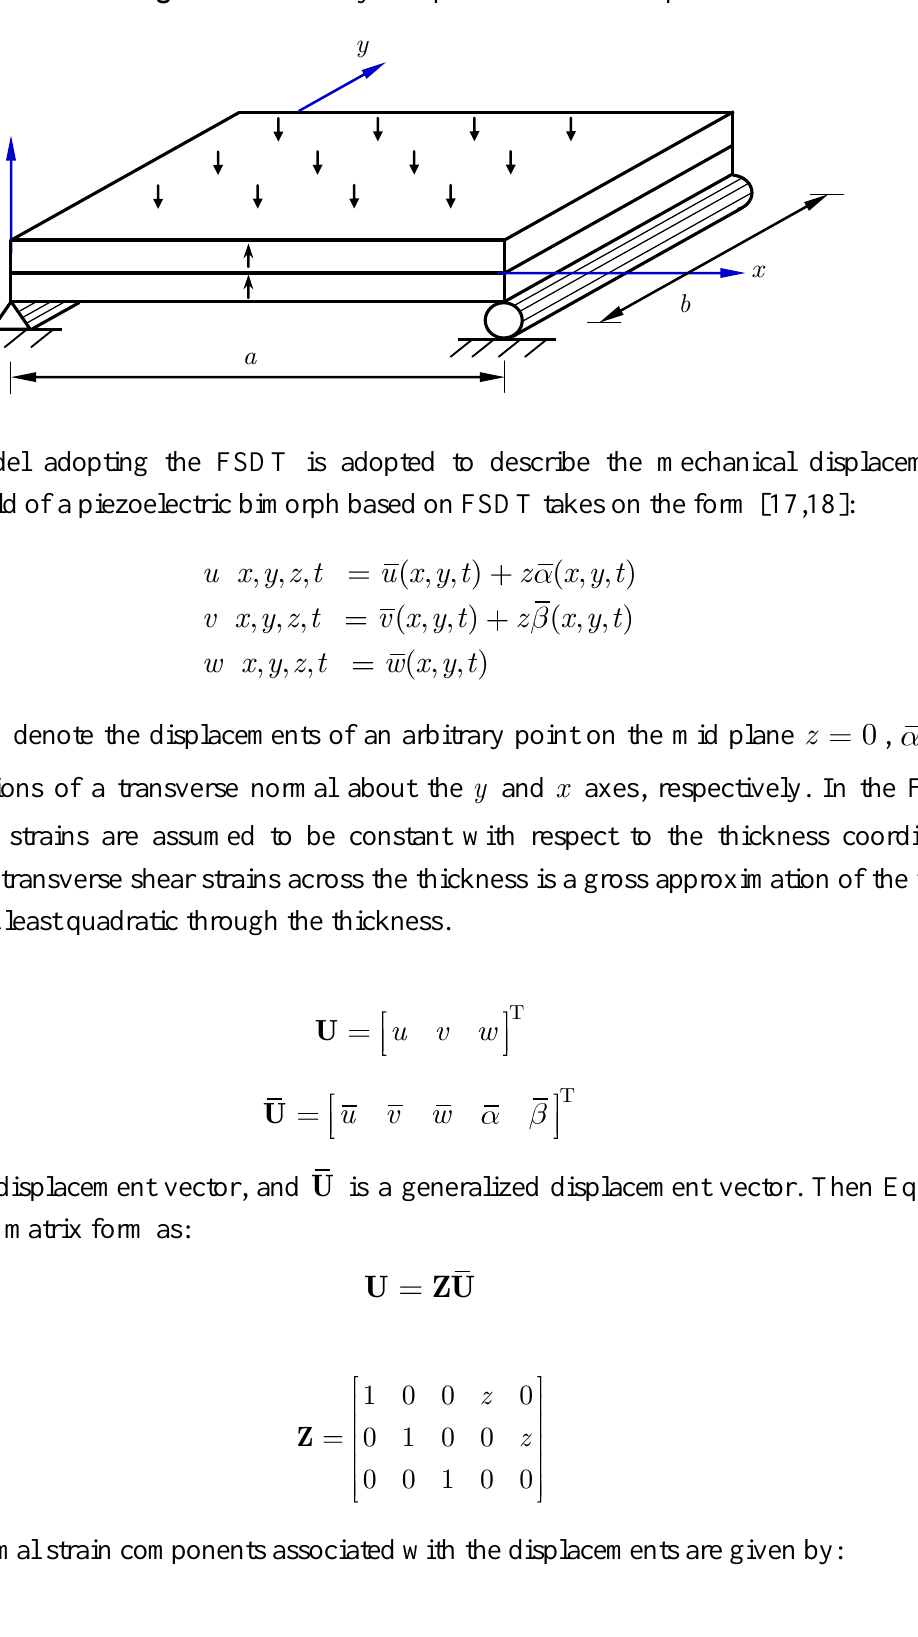
Figure 1. Geometry of a piezoelectric